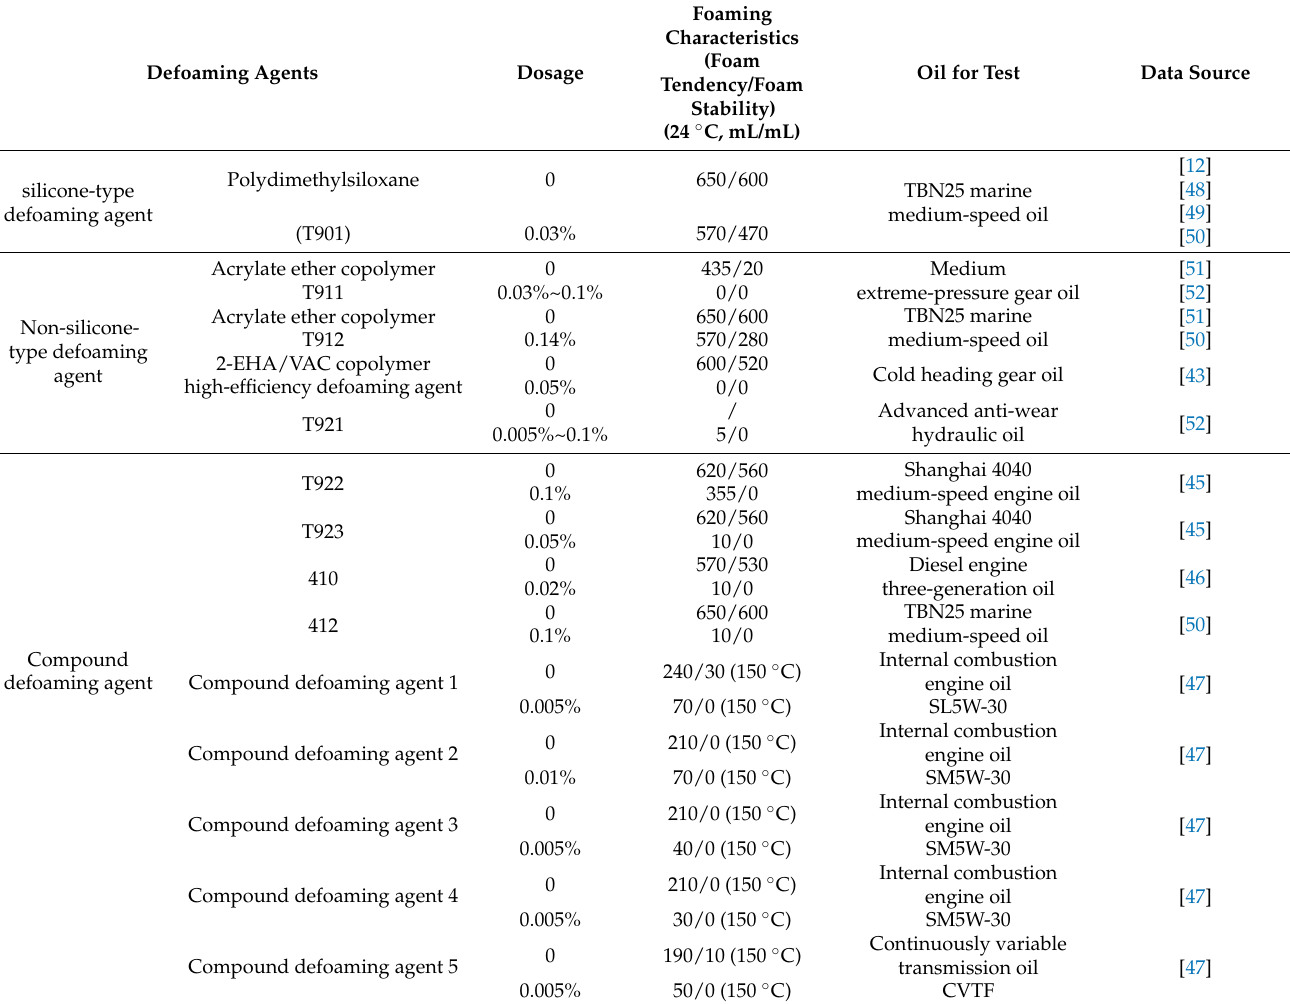
Table 1. Defoaming performance parameters of some typical defoaming